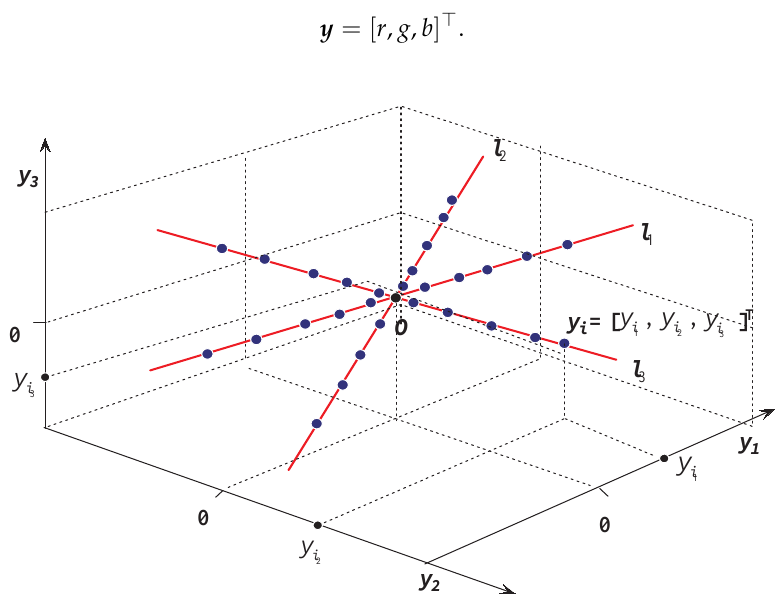
Figure 2. Hyperline clustering, observed data points { y i } T (red